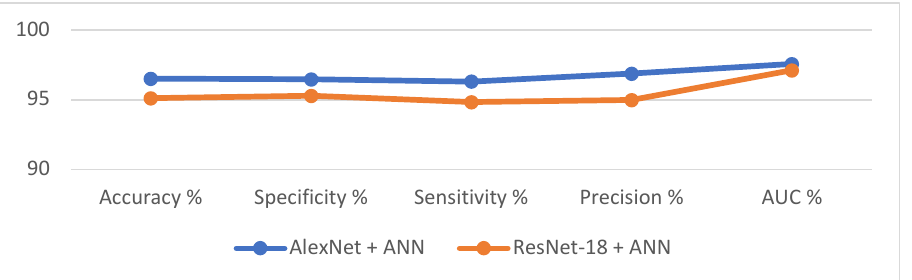
Figure 13. ANN performance based on the hybrid features between CNN models and traditional algorithms.